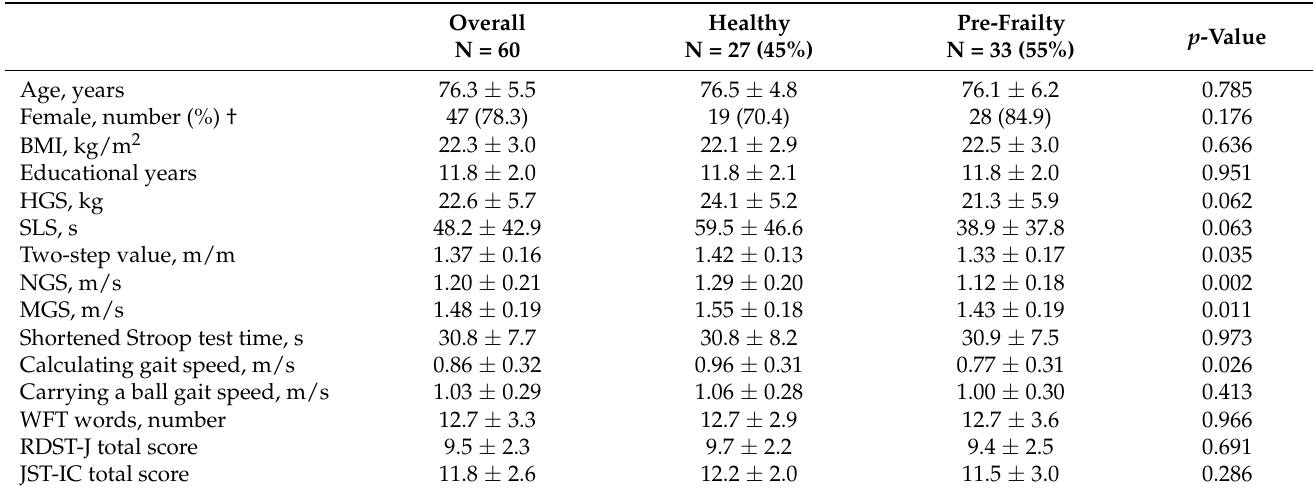
Table 1. Baseline characteristics and motor and cognitive performance of participants.